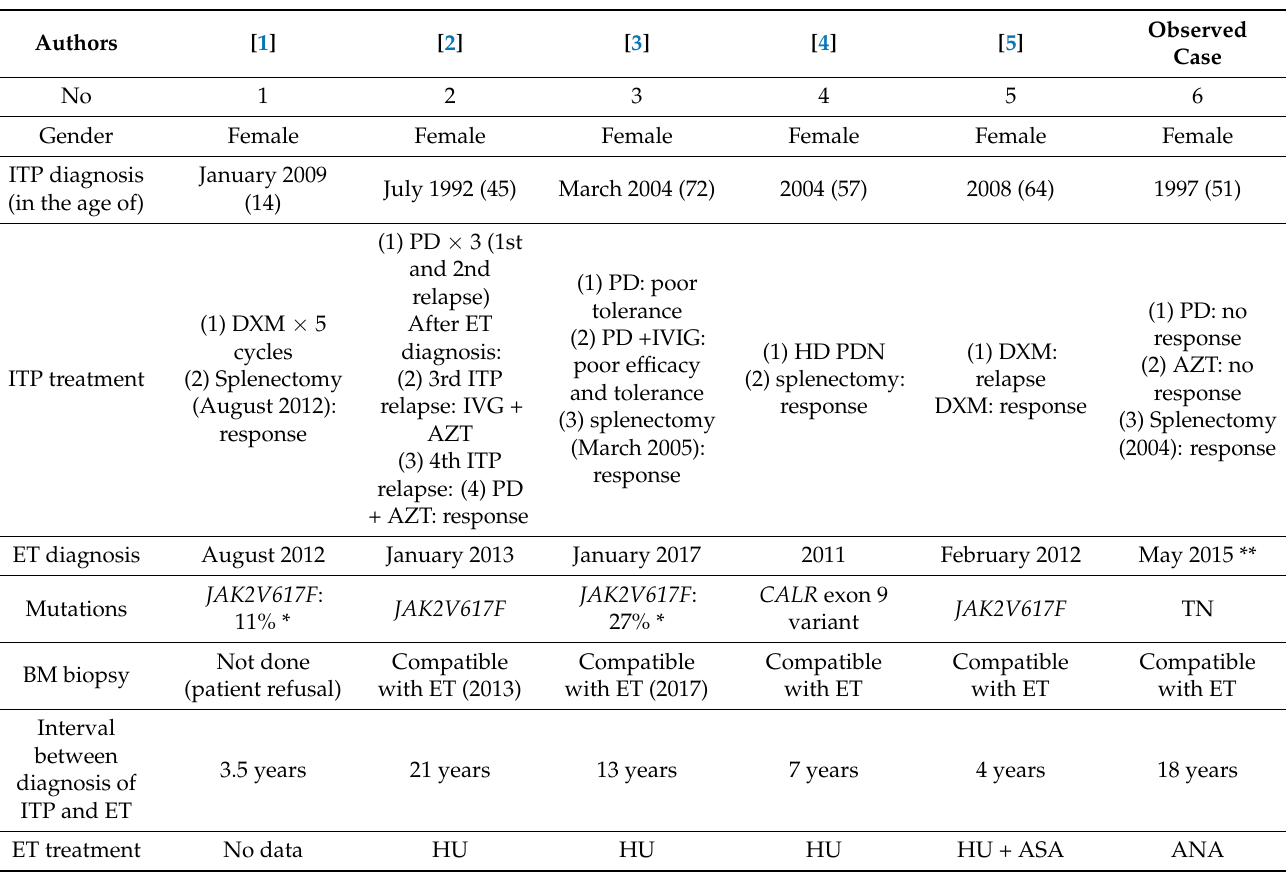
Table 1. Essential thrombocythemia (ET) following primary immune thrombocytopenia (ITP). Bone marrow (BM) biopsy, dexamethasone (DXM) 40 mg/day × 4 days, intravenous immunoglobulin (IVIg), HD PDN: high dose prednisolone, ANA (anagrelide), HU (hydroxyurea), prednisone (PD), azathioprine (AZT), and acetylsalicylic acid (ASA). TTP (thrombotic thrombocytopenic purpura). (1): First line treatment, (2): second line treatment, (3): third line treatment, * allele burden, ** diagnosis of systemic lupus erythematosus